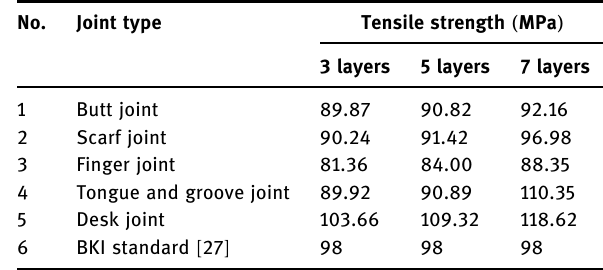
Table 10: Comparison of tensile strength test results with